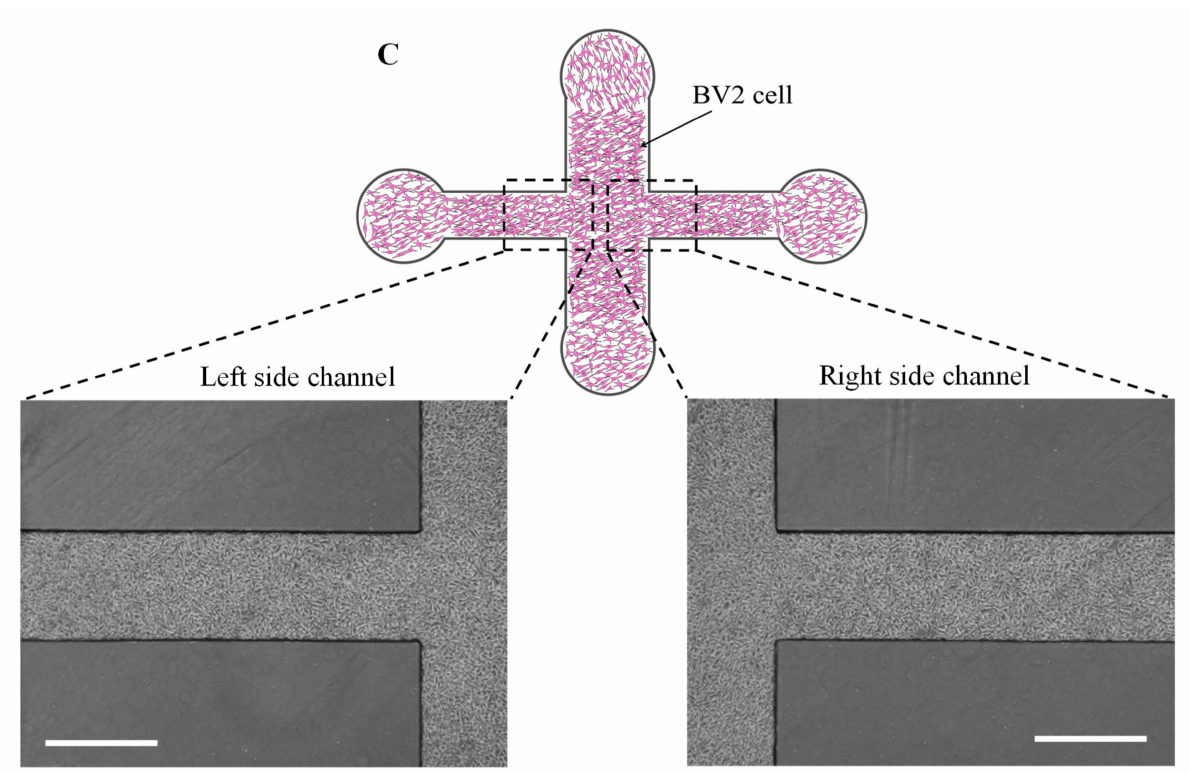
Figure 2. Cell seeding to cell confluence in the microfluidic wound-healing assay. ( A ) cell loading, ( B ) cells attached to the substrate after 40 min, ( C ) confluency of the cells after 12 h, scale bar = 600 µ